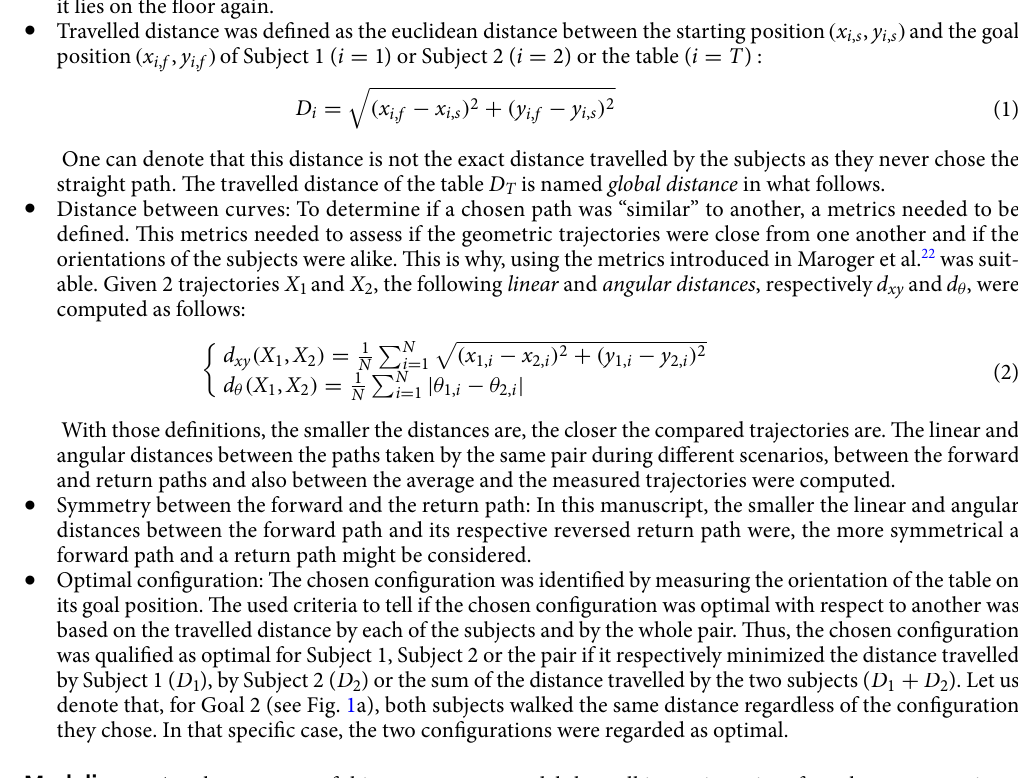
table. Accurately model the subjects’ behaviour is a first step toward the prediction of their motion during a table handling task. To achieve this goal, an OC model optimized through an IOC scheme to fit the average measured trajectories was introduced. As a reminder, the choice to model average trajectories instead of individual ones came from the hypothesis that the same method could be used to accurately simulate single walking humans and walking humans carrying a table. In this section, the focus is on the modeling of the subjects’ average trajec- tories during Scenario 3 only. We did not optimize the model for the other scenarios. We chose to only focus on Scenario 3 because both forward and return paths were performed in this scenario and, thus, it multiplied the number of trajectories to fit for the inverse optimization. Model definition. The OC model introduced in Maroger et al. 22 was adapted to simultaneously generate the CoM trajectories of the two subjects. Originally this model was designed to generate the trajectories of one human walking alone without constraints. Here, the model was modified in order to simulate the trajectories of two humans coupled through a table handling task. This new model is named coupled OC model . Thus, the dynamics of the system is not the dynamics of one holonomic system anymore, but the dynamics of two holo- nomic